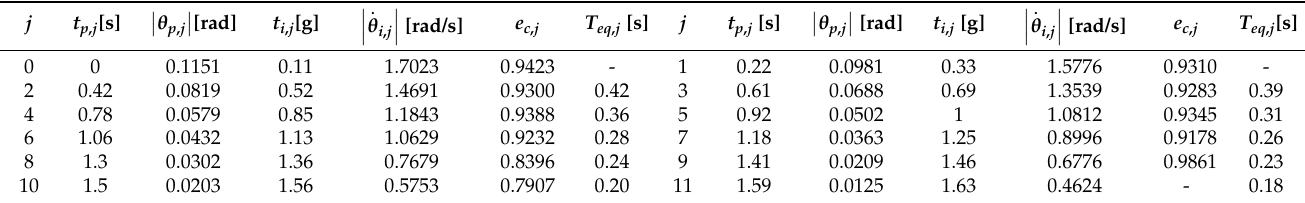
Table 8. Summary of the results of the free oscillation test block type B3.